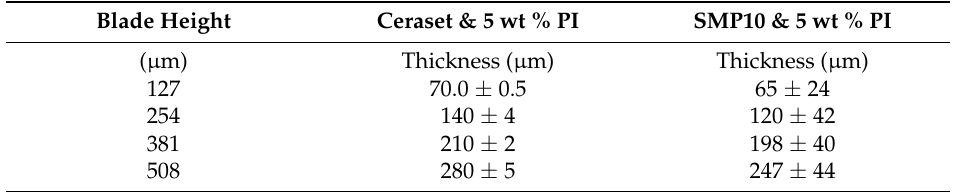
Table 2. Thickness of tape cast films after multiple coat/cure cycles. UV curing was with 120 mW cm − 2